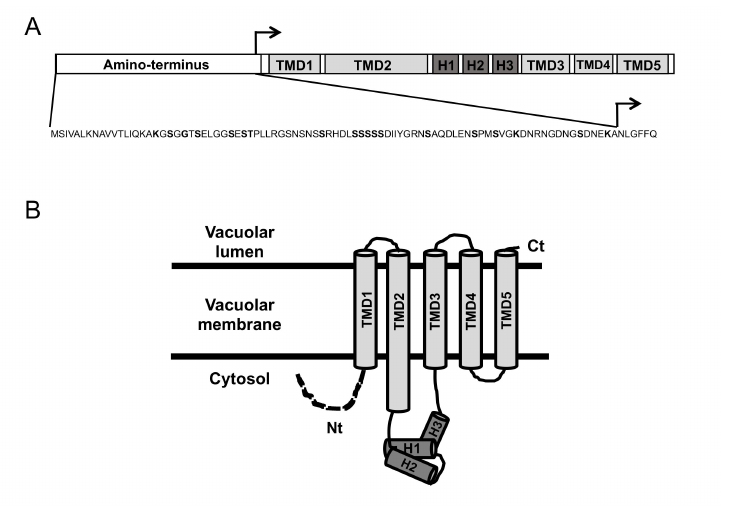
Figure 1. Schematic representation of Ccc1/VIT1 domain organization ( A ) and membrane topology ( B ), based on EgVIT1 structure and protein alignments [11,12]. A and B: Grey rectangles/cylinders represent transmembrane domains (TMDs); dark grey rectangles/cylinders represent three helices. A: White rectangles represent the Nt domain, whose amino acid sequence is indicated below. Bold letters indicate phosphorylated and ubiquitylated residues, as well as mutation G22R in Malaysian yeast strains [13–15]. Black arrow indicates where Nt ∆ Ccc1 protein